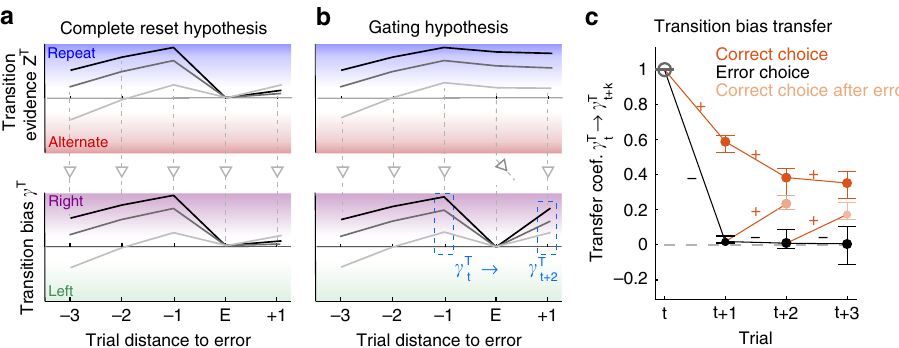
Fig. 5 Transition bias is reset after errors but accumulated transition evidence is maintained. a , b Schematics showing three example traces of the transition accumulated evidence z T t (top) and transition bias on current response γ T t (bottom) in two hypothetical scenarios. To facilitate visualization, the pattern of responses in all example traces was R + R + R + ER + . a Complete reset hypothesis: after an error at t , both variables reset z T t + 1 ≃ γ T t + 1 ≃ 0. Evidence z T t + 2 is then built up de novo, implying that biases before ( γ T t ) and after ( γ T t + 2 ) the reset are independent. b Gating hypothesis: after an error, evidence z T t + 1 is maintained but it does not convert into a bias, leading to the reset γ T t + 1 ≃ 0. After a correct response at t + 1, the conversion is recovered and the value γ T t + 2 correlates with γ T t . In the example shown, this implies that the sorting of γ T t across traces is maintained for γ T t + 2 . c Transfer coef fi cient γ T t → γ T t + k versus trial lag k quanti fi es the degree to which the transition bias at trial t is predictive of the bias on subsequent trials (blue dashed boxes in b ). It is calculated separately depending on the outcome of each trial (colored lines show rewarded choices and black lines error choices; see the section 2.6. in Supplementary Methods for details). While the transfer coef fi cient vanishes after errors (i.e., reset of the bias; black dots), a correct response following an error (light orange) brings it close to the value obtained when there are no errors (dark orange dots). This implies that the information about the value of the bias γ T t is maintained when the bias is reset (i.e., gating